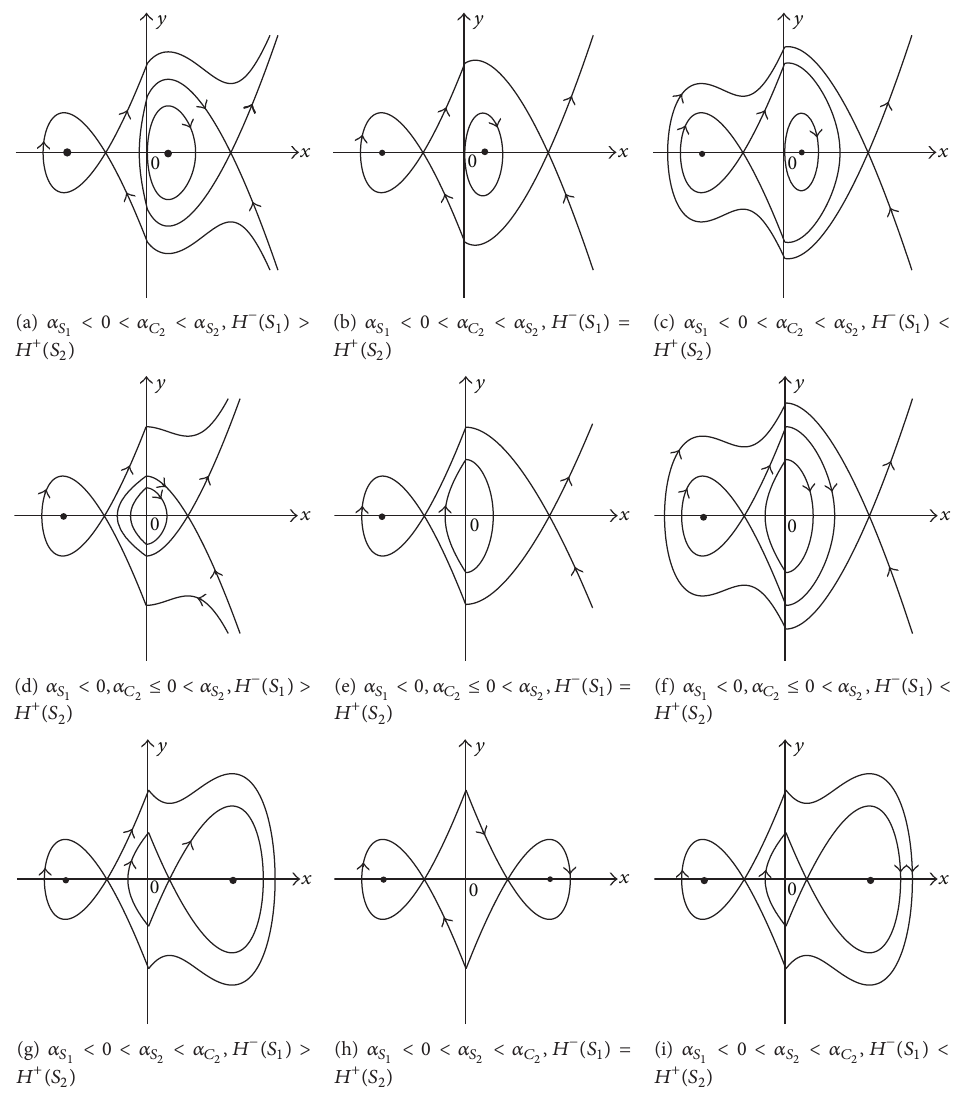
Figure 2: Possible portraits of (1) | 𝜀=0 with two saddles and a generalized closed